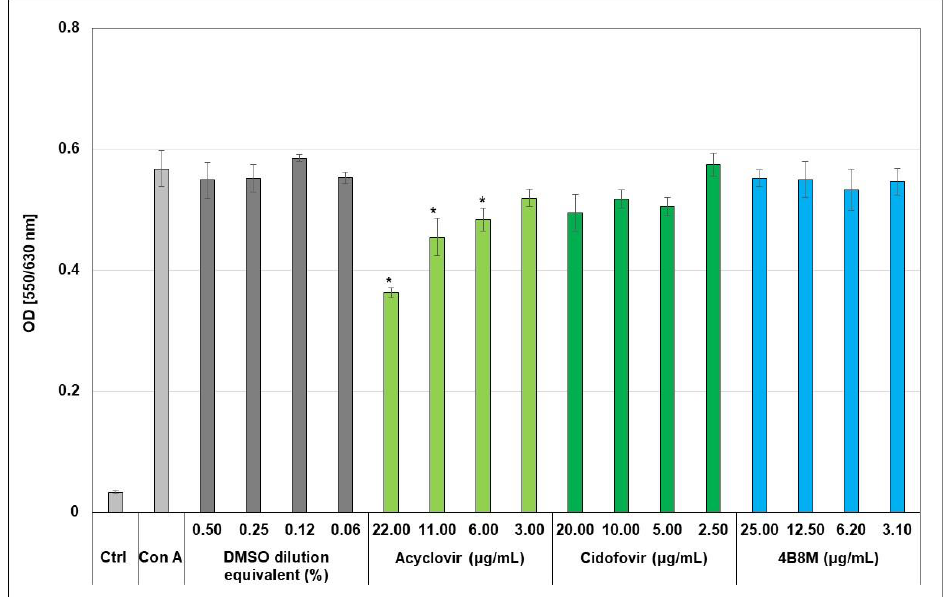
Figure 3. Effects of 4B8M and the reference compounds on concanavalin A (ConA)-induced splenocyte proliferation. 4B8M and the reference drugs were added at the indicated concentrations.